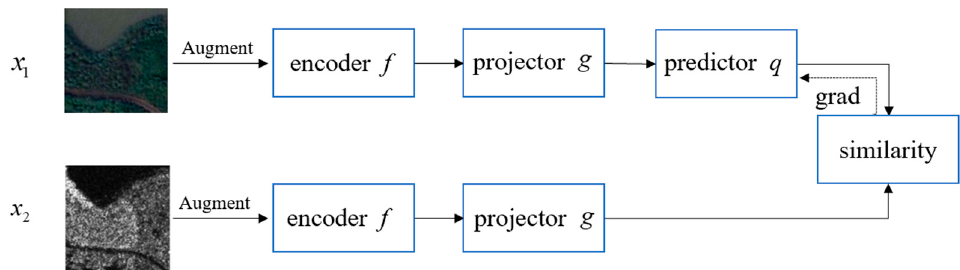
Figure 6. Structure of SimSiam with SAR-optical images.